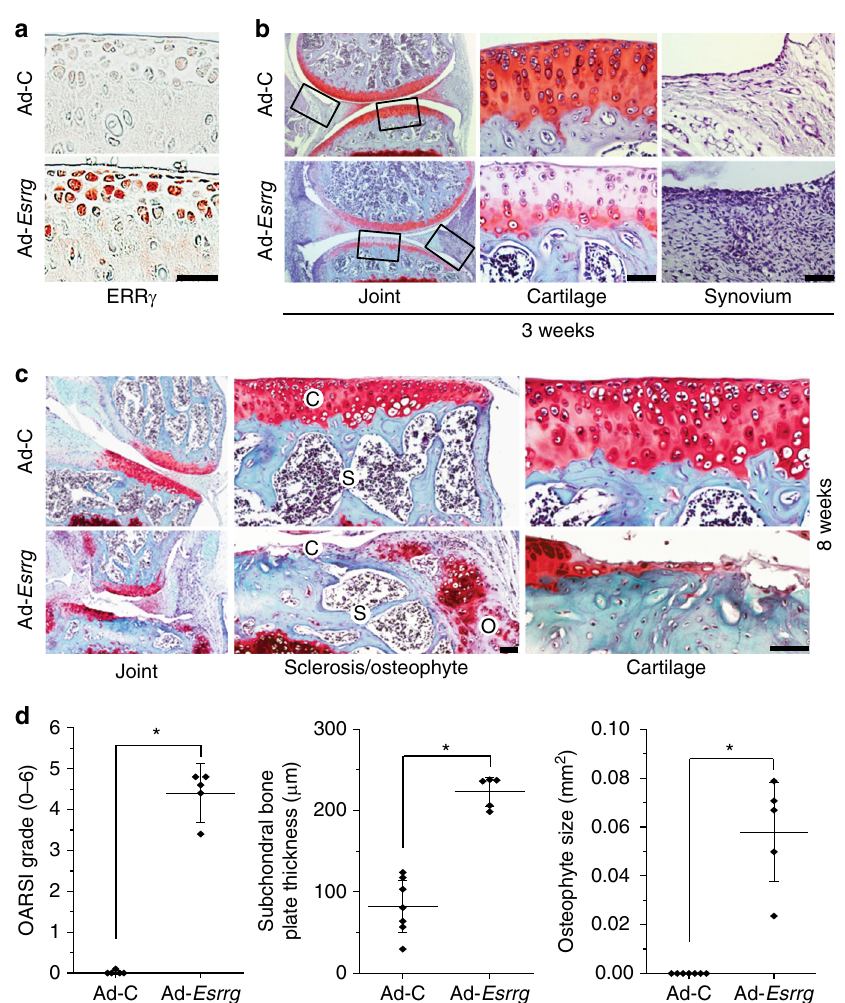
Fig. 3 Overexpression of ERR γ in joint tissue causes OA in mice. a , b WT mice were IA-injected with Ad-C (control) or Ad- Esrrg to overexpress ERR γ in the joint tissues. Three weeks after the fi rst injection, sections of mouse joint tissues were immunostained for ERR γ ( a ). Cartilage destruction and synovial in fl ammation were determined by safranin-O staining and H&E staining, respectively ( b ). c , d WT mice were IA-injected with Ad-C (control) or Ad- Esrrg to overexpress ERR γ in mouse knee joint tissues. Mice were killed 8 weeks after the fi rst injection. Representative images of safranin-O staining, showing the whole joint (40×), subchondral bone sclerosis and osteophyte formation (200×), and cartilage destruction (400×) ( c ). OARSI grade (for cartilage destruction), subchondral bone plate thickness (for subchondral bone sclerosis), and osteophyte size were quanti fi ed ( d ; n ≥ 5 mice per group). Values are presented as means ± s.e.m. (* P < 0.005). Two-tailed t test and Mann – Whitney U test. Scale bar: 50 μ m. C, cartilage; S, subchondral bone; O,